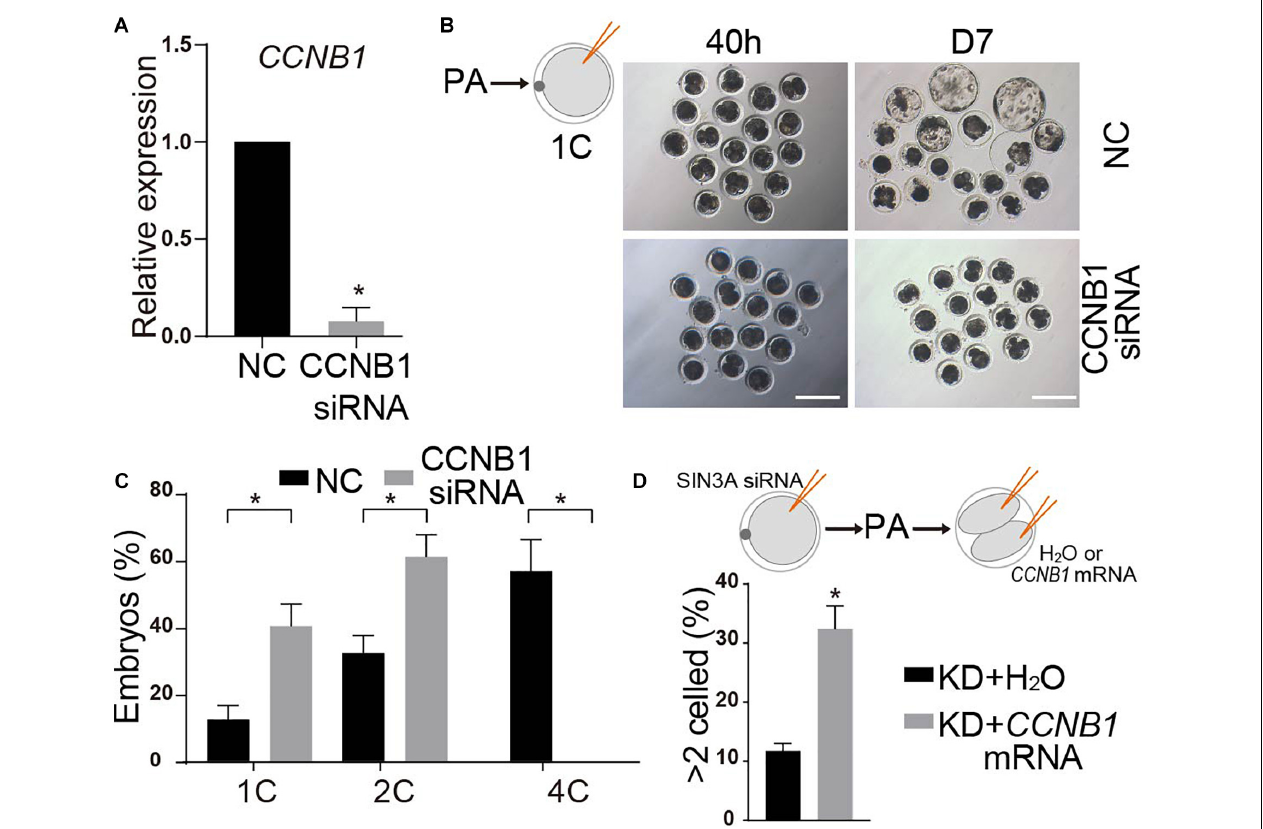
FIGURE 7 | CCNB1 deficiency leads to two-cell block in SIN3A knockdown embryos. (A) qPCR validation of the knockdown efficiency of CCNB1 siRNA. Embryos were collected at 32 h after parthenogenetic activation. The experiments were independently repeated three times. Values are shown as mean ± SEM, * P < 0.05. (B) NC-siRNA or CCNB1-siRNA was introduced into 1C embryos (19 h after parthenogenetic activation) and the representative images of embryos at D7 are shown. (C) The developmental rates of two-cell and four-cell embryos were recorded at 40 h after parthenogenetic activation according to the experiment shown in (B) . The experiment was independently repeated three times, all data were represented as mean ± SEM, * P < 0.05. (D) H 2 O or CCNB1 mRNA were microinjected into both blastomere of SIN3A-depleted two-cell embryos, and then the percentage of embryos developing beyond two cells was counted. The experiment was independently repeated three times, all data were represented as mean ± SEM, * P <